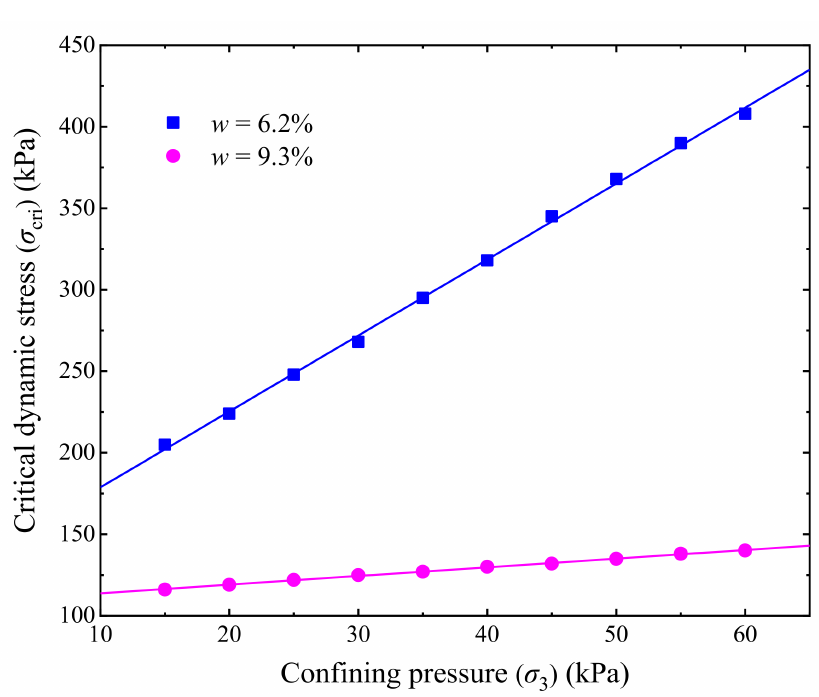
Figure 10. Relationship between critical dynamic stress and confining